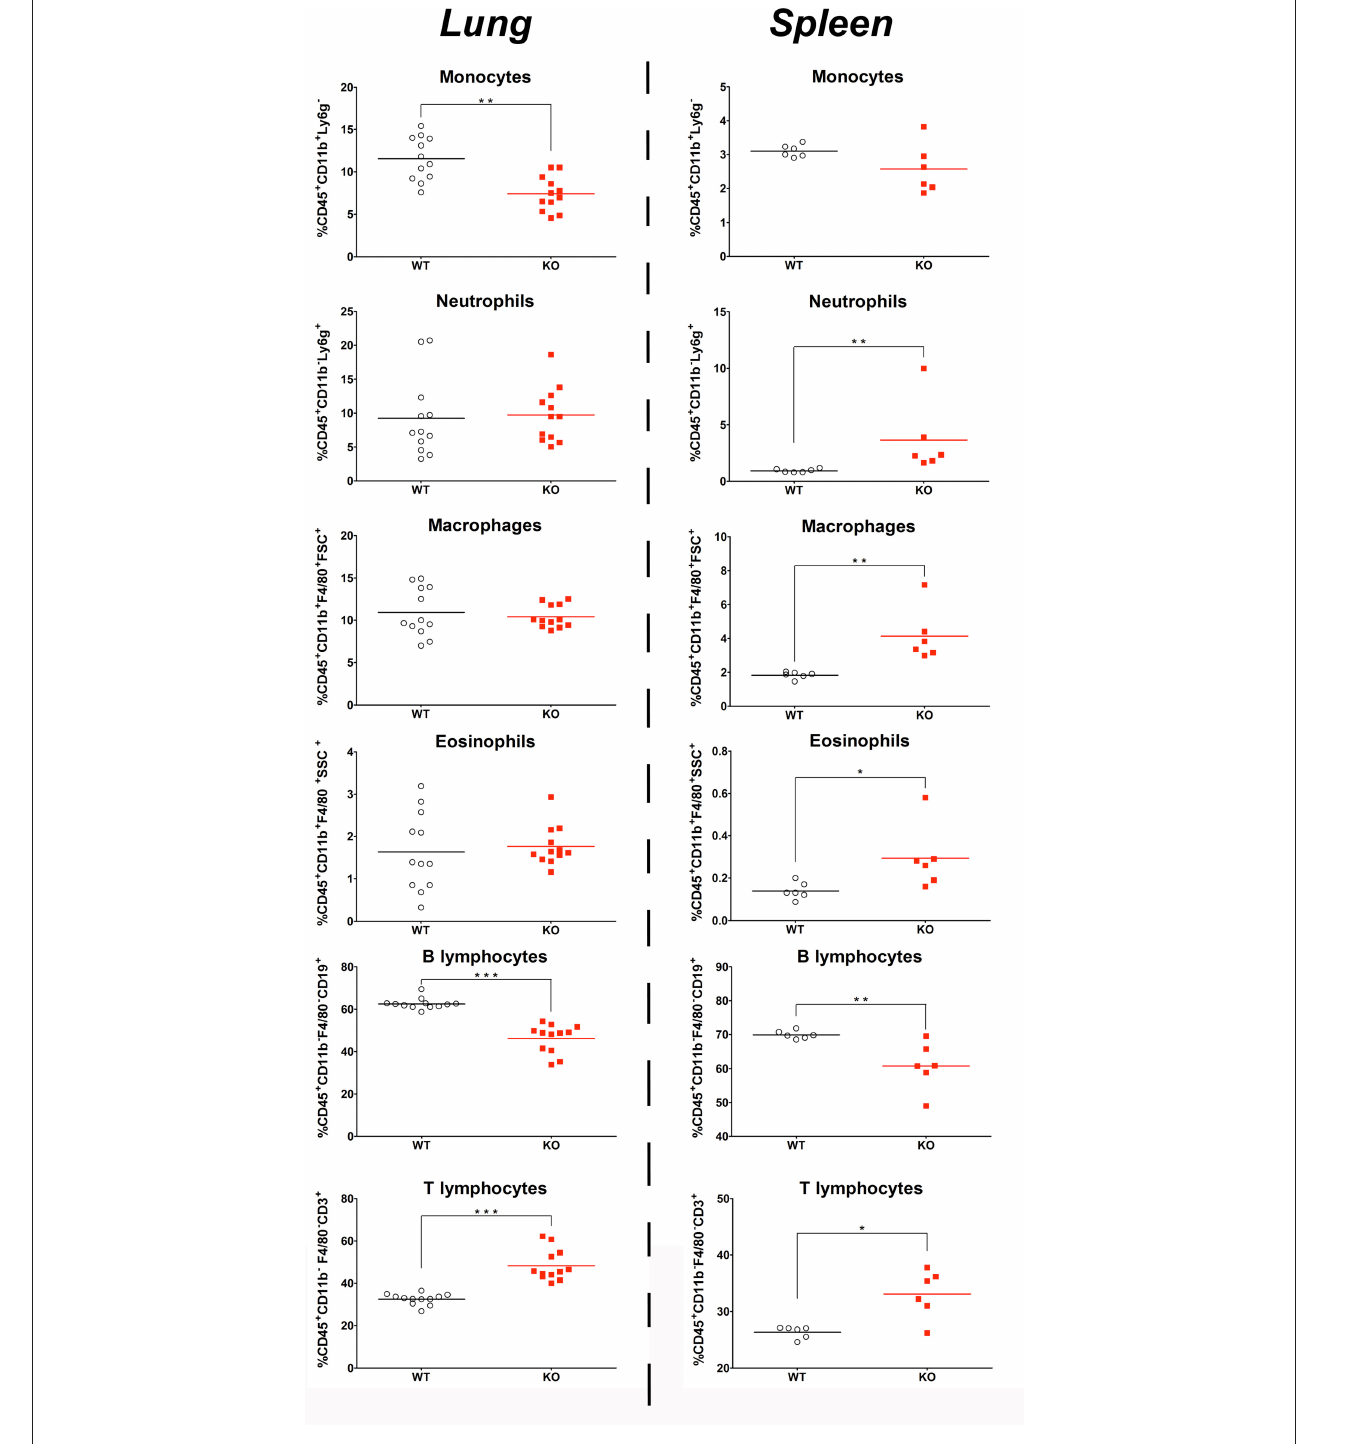
FIGURE 5 | Basal percentage of immune cell in the lungs and spleen of KO and WT mice. Percentage of immune cells: monocytes, neutrophils, macrophages, eosinophils, B lymphocytes, and T lymphocytes in CD45.2 positive cells was measured in the lung (left) and spleen (right) of WT ( ◦ ) and KO ( ) mice. All results are presented as individual and mean response and repeated as 3 independent experiments. N = 5–12 mice per group. * p < 0.05, ** p < 0.01 and *** p < 0.01 (unpaired Student t -test).